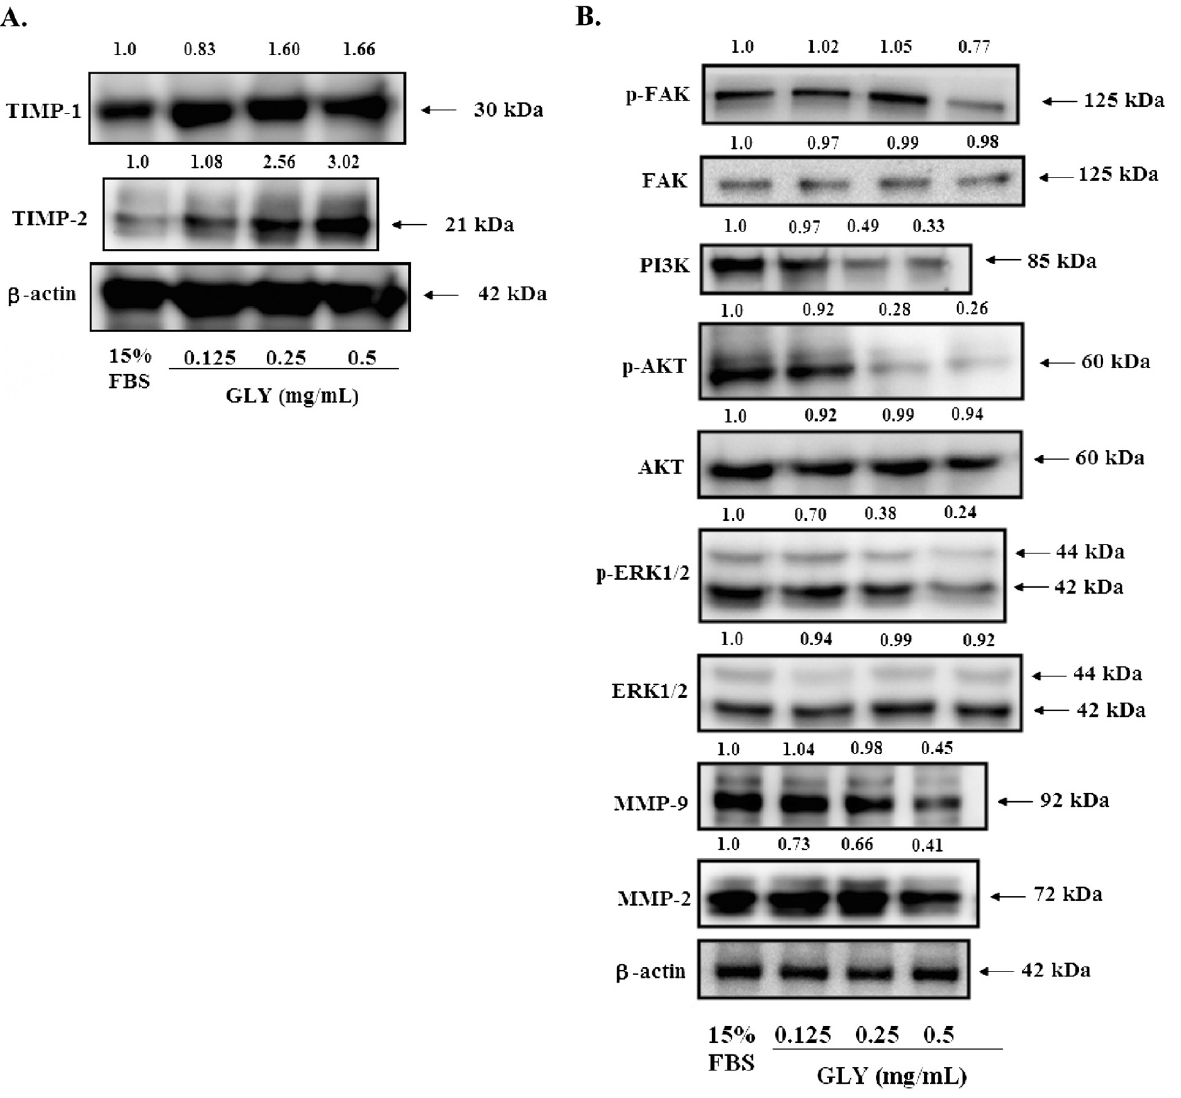
Figure 4 Molecular mechanisms of GLY on FBS-induced VSMCs. ( A ). Effects of GLY on TIMP-1, TIMP-2, MMP-2, MMP-9 proteins expression. VSMCs were treated with 0.125, 0.25 and 0.5 mg/mL for 24 h, and cell lysates were subjected to SDS-PAGE followed by Western blotting. ( B ). Dose-dependent effects of GLY on the protein expression level of FAK, the phosphorylated FAK, ERK1/2, the phosphorylated ERK1/2, PI3K, MMP-2, MMP-9, AKT and the phosphorylated AKT. VSMCs were treated with 0.125, 0.25 and 0.5 mg/mL of GLY for 24 h. The expression of these proteins were analyzed by Western blotting. β -actin was used as a loading